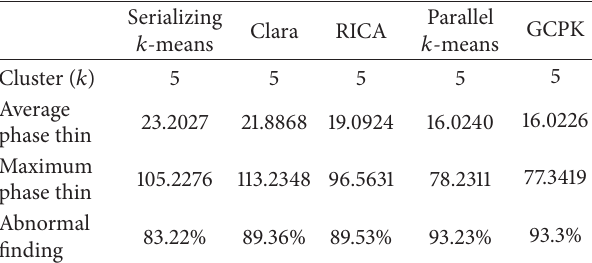
Table 1: Thin contrast of DataSet1.